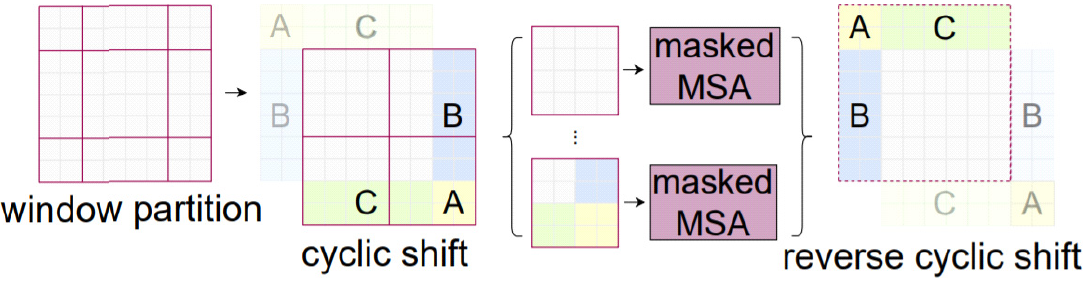
Figure 5. Illustration of high efficiency of batch computation for self-attention in shifted window partitioning [69].